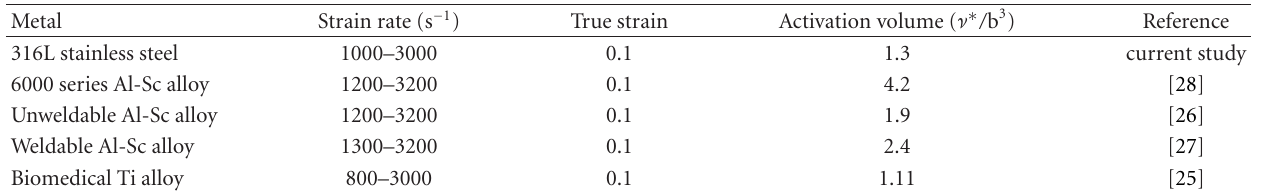
Figure 8: SEM fractographic images of 316L stainless steel specimens deformed at strain rate of 5 × 10 3 s − 1 and temperatures of (a) 25 ◦ C and (b) 200 ◦ C. Table 4: Activation volume of various alloys at 25 ◦ C.